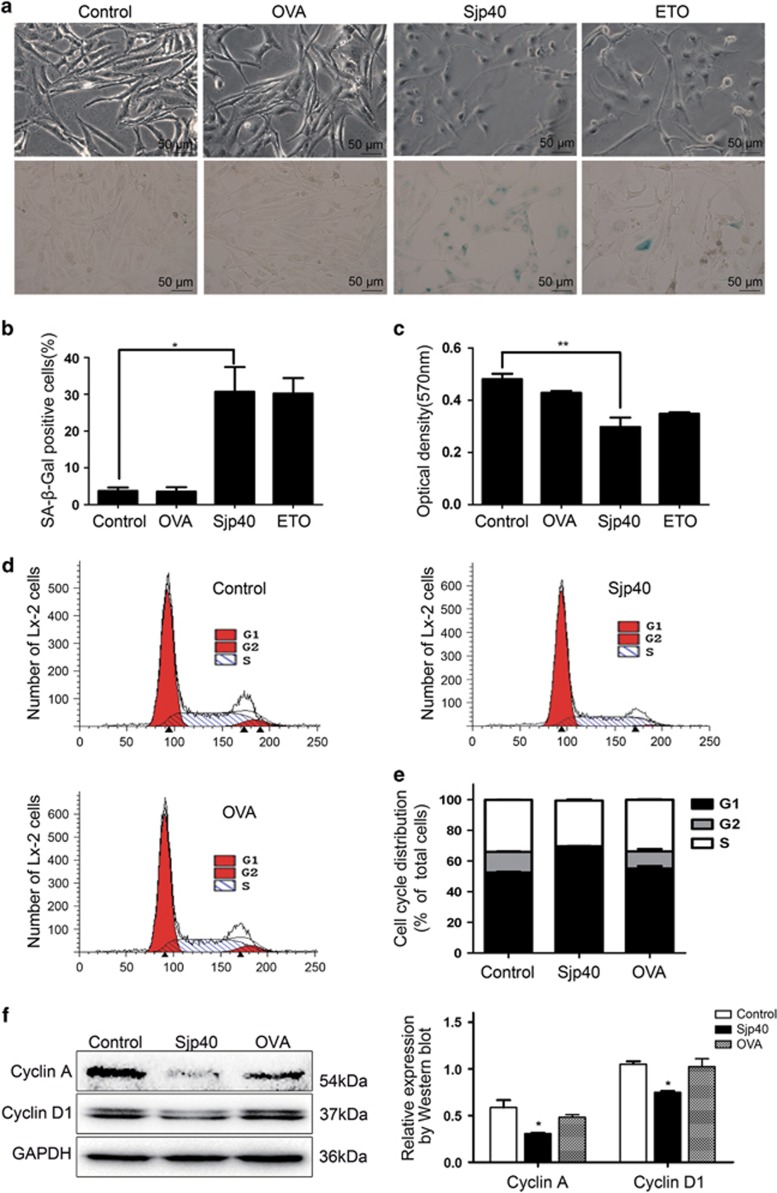
Sjp40 induces a senescence-like phenotype and inhibits cell growth in activated HSCs. (a) Effects of Sjp40 (20 μg/ml) on cell senescence in LX-2 cells were determined via senescence-associated β-galactosidase assay (original magnification × 200). Bar: 50 μm. (b) The graph represents quantitative analysis of the percentage of SA-β-Gal-positive cells (%). Data were expressed as the mean±S.E.M. of three or four independent trials. *P<0.05 compared with the control group. (c) Effect of Sjp40 (20 μg/ml) on the proliferation of LX-2 cells. LX-2 cells proliferation was examined using the MTT assay. Data were expressed as the mean±S.E.M. of three or four independent trials. **P<0.01 compared with the control group. (d) Flow cytometric analysis was applied to analyze Sjp40-induced cell cycle arrest of LX-2 cells in the G1 phase. (e) Quantitative analysis of cell cycle distribution graph describing the role of Sjp40 in regulating the G1 phase of cell cycle arrest. Data were expressed as the mean±S.E.M. of three or four independent trials. (f) The expression of Cyclin A and D1 by analysis of western blot. All values were expressed as the mean±S.E.M. of three or four independent trials. *P<0.05 compared with the control group